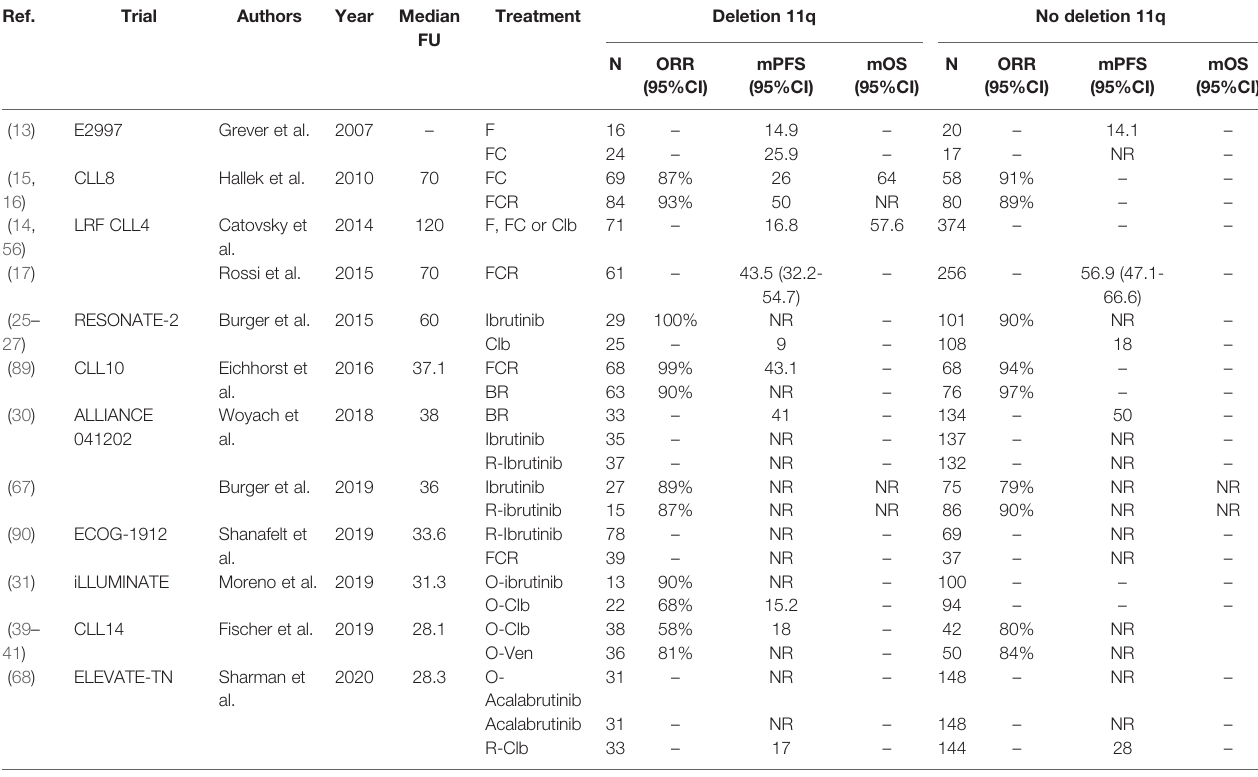
TABLE 3 | An overview of clinical trials comparing fi rst-line treatment regimens for patients with deletion 11q.